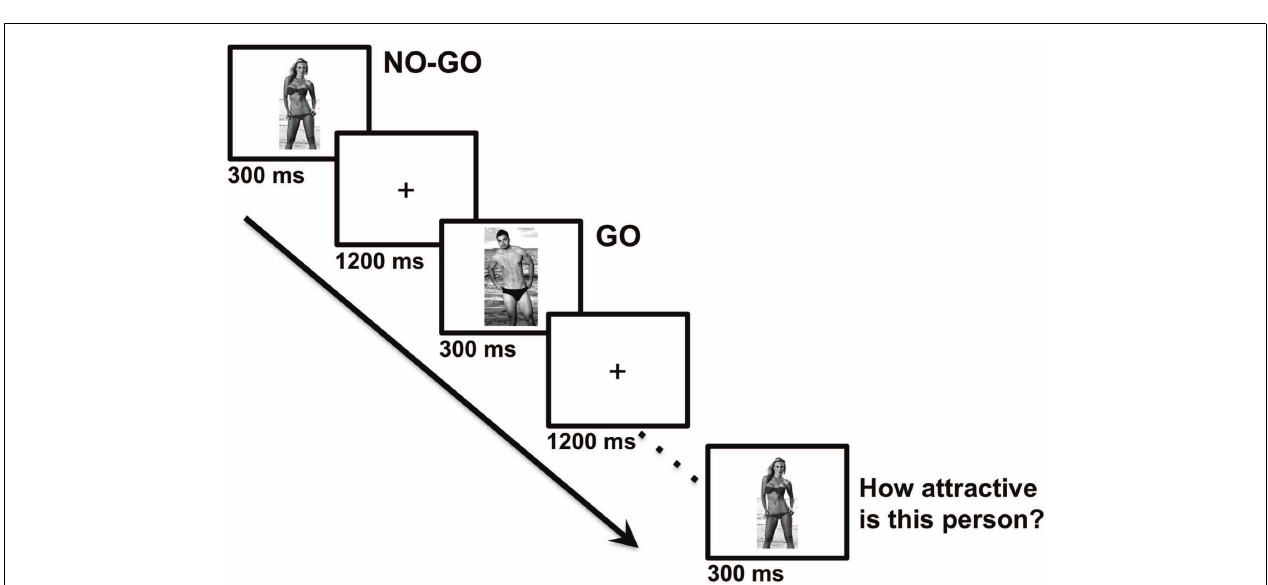
“No-go” stimuli that require the response to be withheld. After every 12 Go/No-go trials, the same stimuli are affectively evaluated. Photo credits Evan Balbier and Elmo Love.